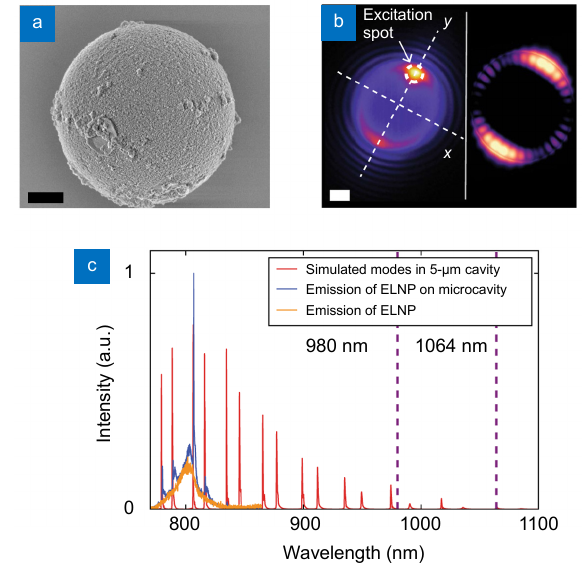
Fig. 5 | ( a ) Scanning electron micrograph of a polystyrene bead coated with ELNPs. ( b ) Left: wide-field image of a lasing microsphere. Right: simulated field distributions in the x – y plane. ( c ) Simulated NIR spectra of WGMs supported by a 5-µm polystyrene microsphere. Figure reproduced from ref. 66 , Springer